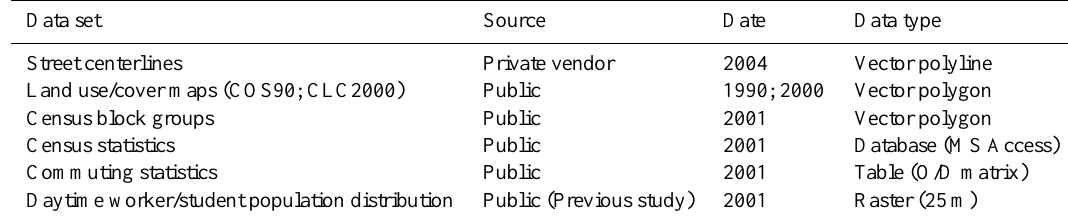
Table 2. Main input data sets used for modeling population